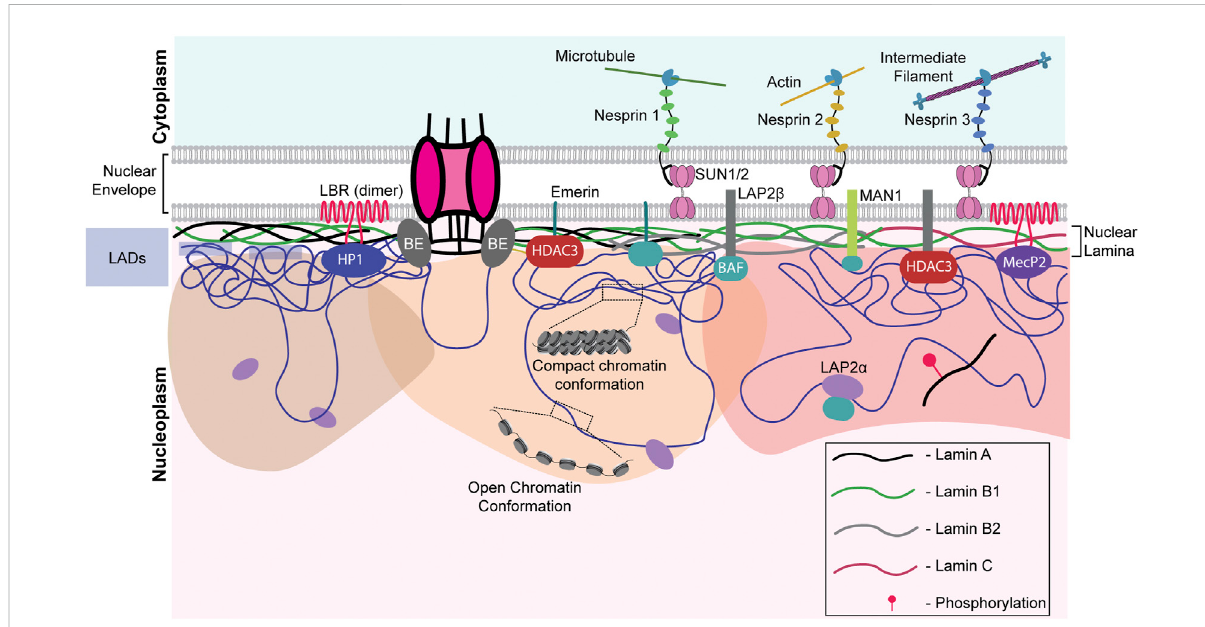
FIGURE 2 Nuclear envelope architecture and its role in genome organization. A schematic model showing the INM proteome involved in maintaining genome organization. Nesprins communicate external mechanical cues to the nucleus via the SUN1/2 complex. The regions of the genome contacting thenuclearlamina,theLADs, aremaintained inaheterochromatic state.Phosphorylated lamin Abinds toactive enhancersinthenuclear interior.LAP2 α interactswithintra-nuclearlaminA/Candcouldberegulatingitsfunctioning.ChromatinremodelerssuchasHDACsandsirtuins are often associated with the INM proteins such as emerin, MAN1, LAP2 β , lamins, and LBR. NPCs are also associated with chromatin. LAP2 α - lamina Associated Peptide 2 α , LBR - lamin B receptor, BE - Barrier Element, HP1 — Heterochromatin Protein 1, HDAC — histone deacetylase, SUN1/2 —